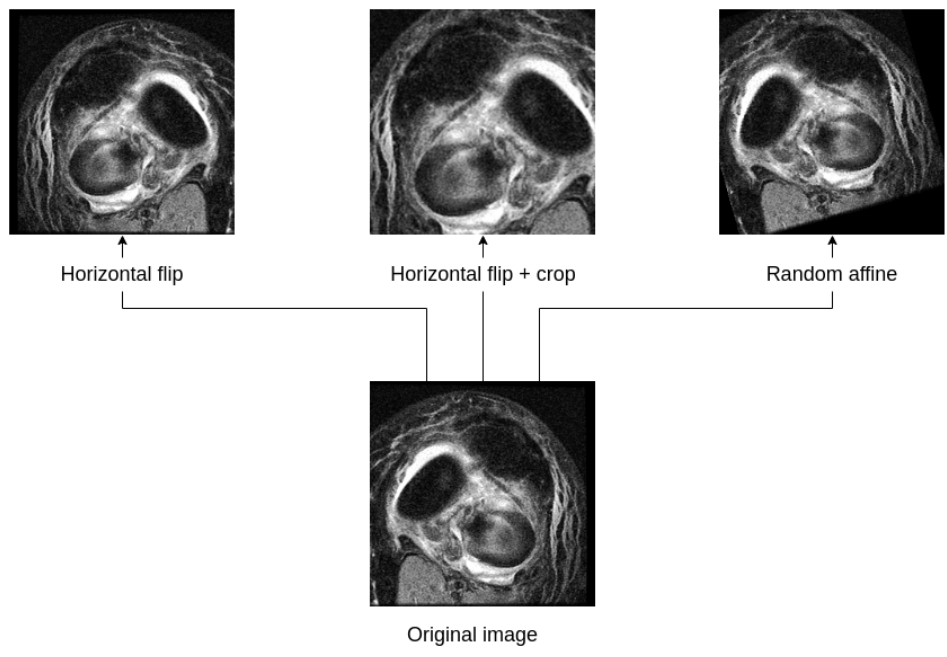
Figure 4. Random input image transforms applied to a middle axial image slice to augment the original MRNet imaging